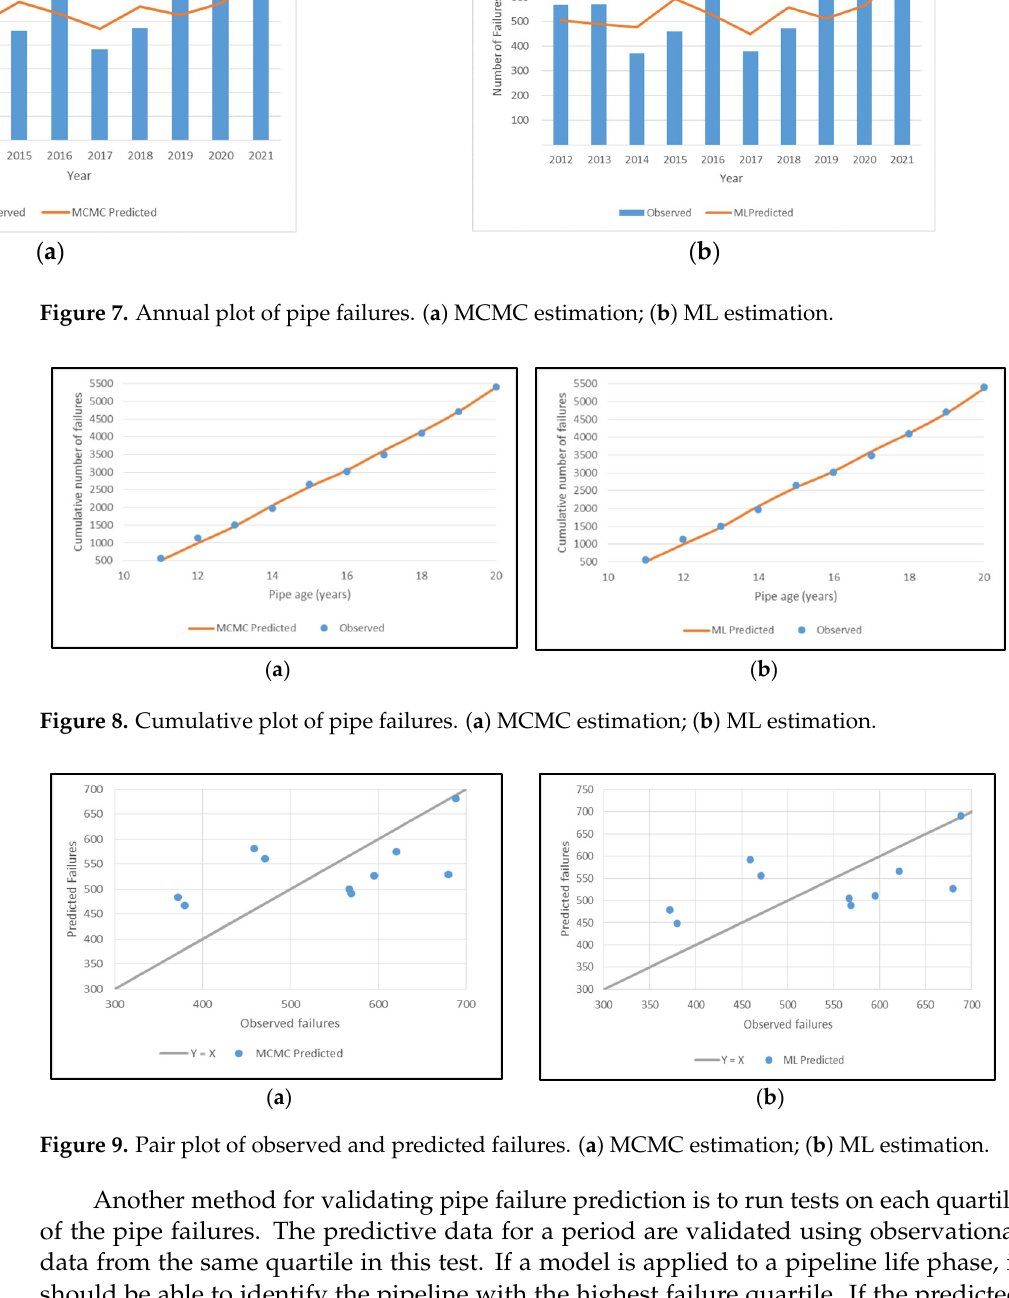
Table 6. Quartile of the pipe failures with MCMC